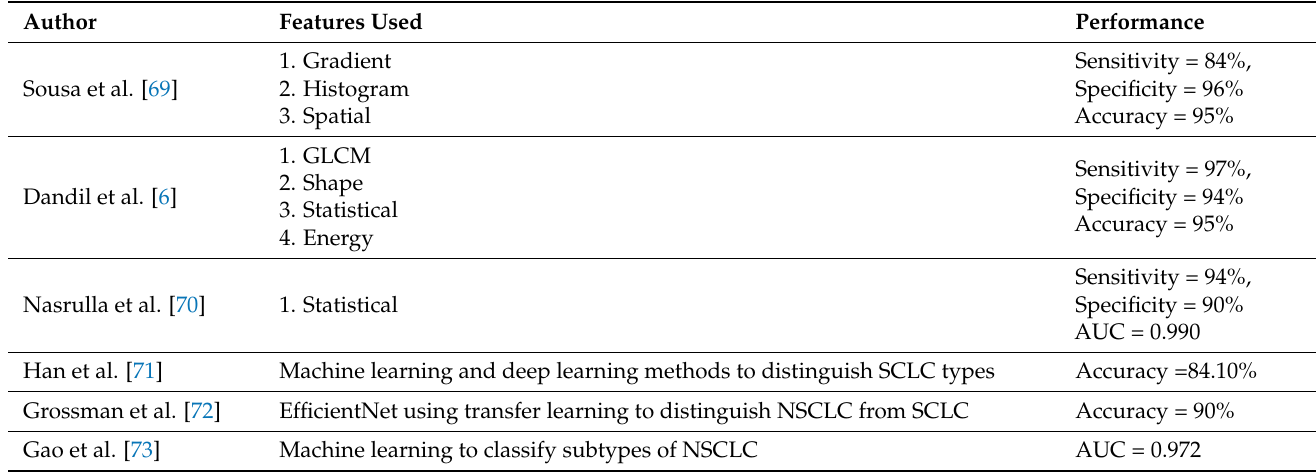
Table 1. Lung cancer detection performance based on data augmentation with gamma correction Table 2. Comparison of findings with previous (gamma = 0.5), and applying the ML methods.